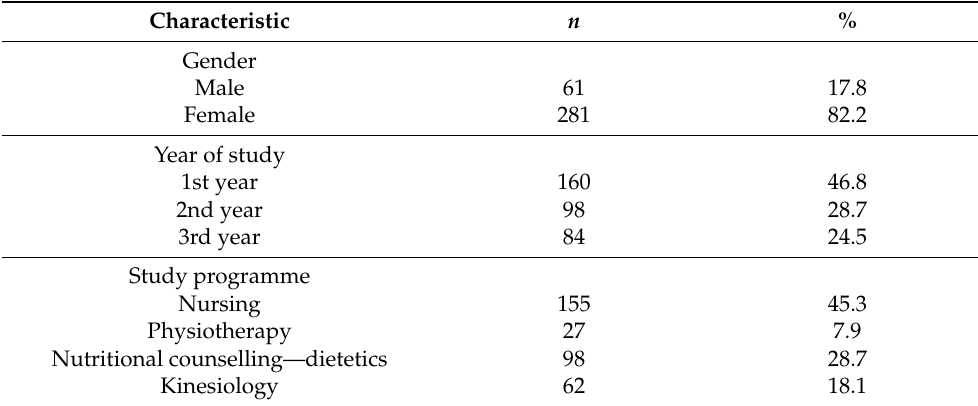
Table 1. Demographic and other characteristics of the participants in step 3 ( n =